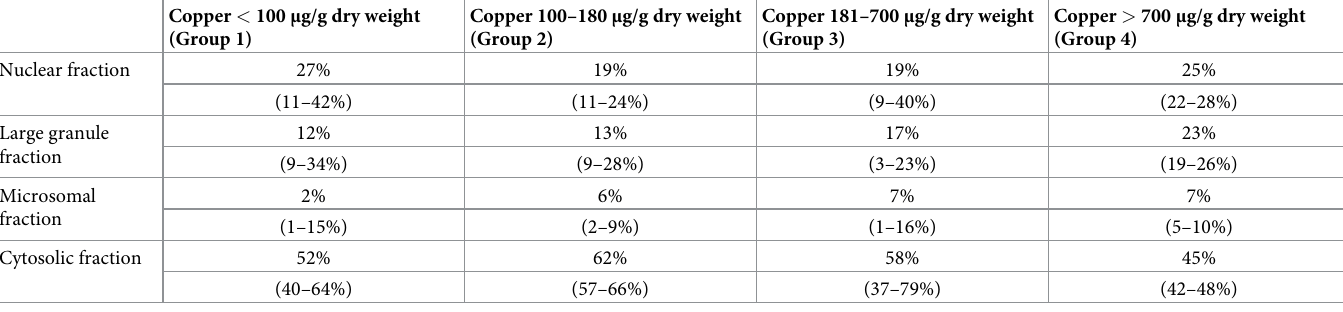
Table 3. Summary of the intracellular distribution of copper in liver specimens from cats with copper concentrations < 100 μ g/g dry weight (Group 1; n = 5), 100– 180 μ g/g dry weight (Group 2; n = 8), 181–700 μ g/g dry weight (Group 3; n = 14), > 700 μ g/g dry weight (Group 4; n = 2).